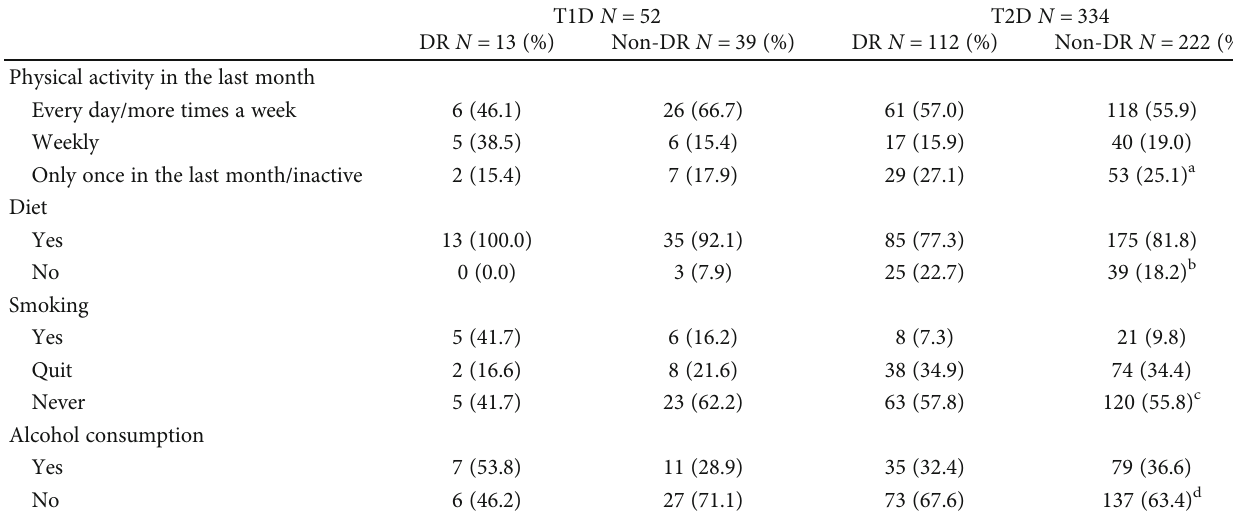
Table 3: Health behavior of the study